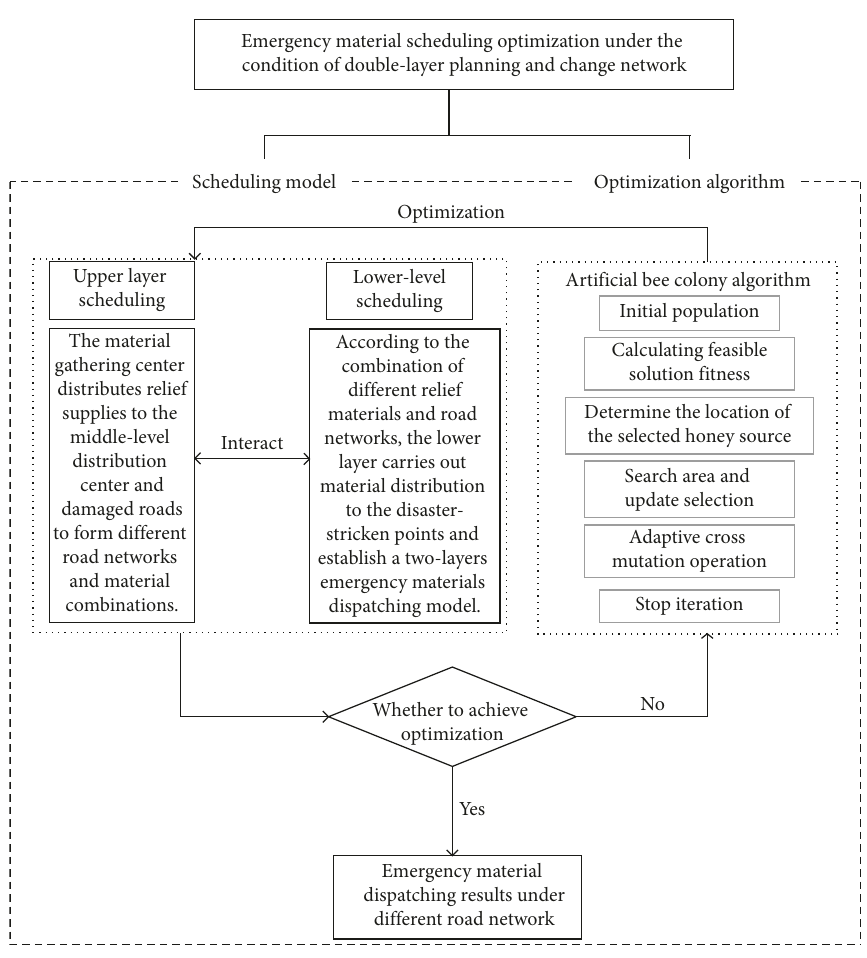
Figure 1: Research